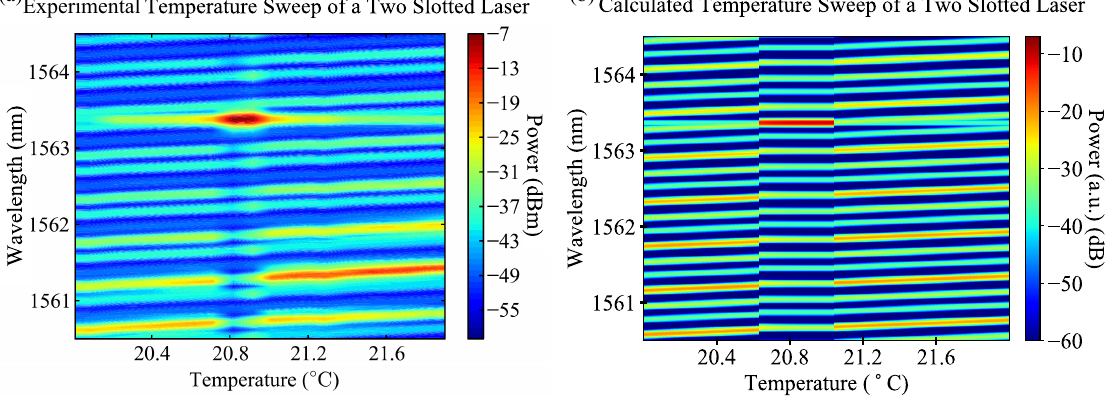
Figure 5. Experimental and calculated temperature sweeps of an optically-injected 600 µ m-long two-section slotted FP device, with a single etched slot in the centre of the device separating the sections. In each case, the slave laser was under optical injection at a wavelength of 1563.36 nm. ( a ) Experimental sweep from [12]. ( b ) Calculated sweep for an injection ratio of 6.13 × 10 − 4 .